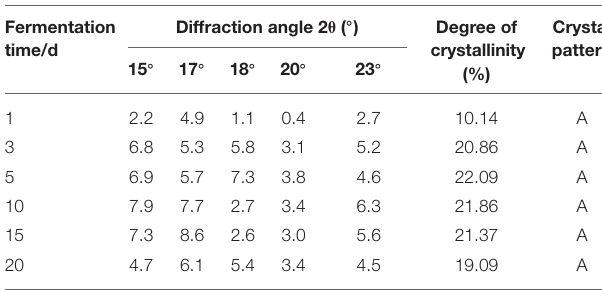
TABLE 7 | Effect of natural fermentation on the crystallinity of corn ballast